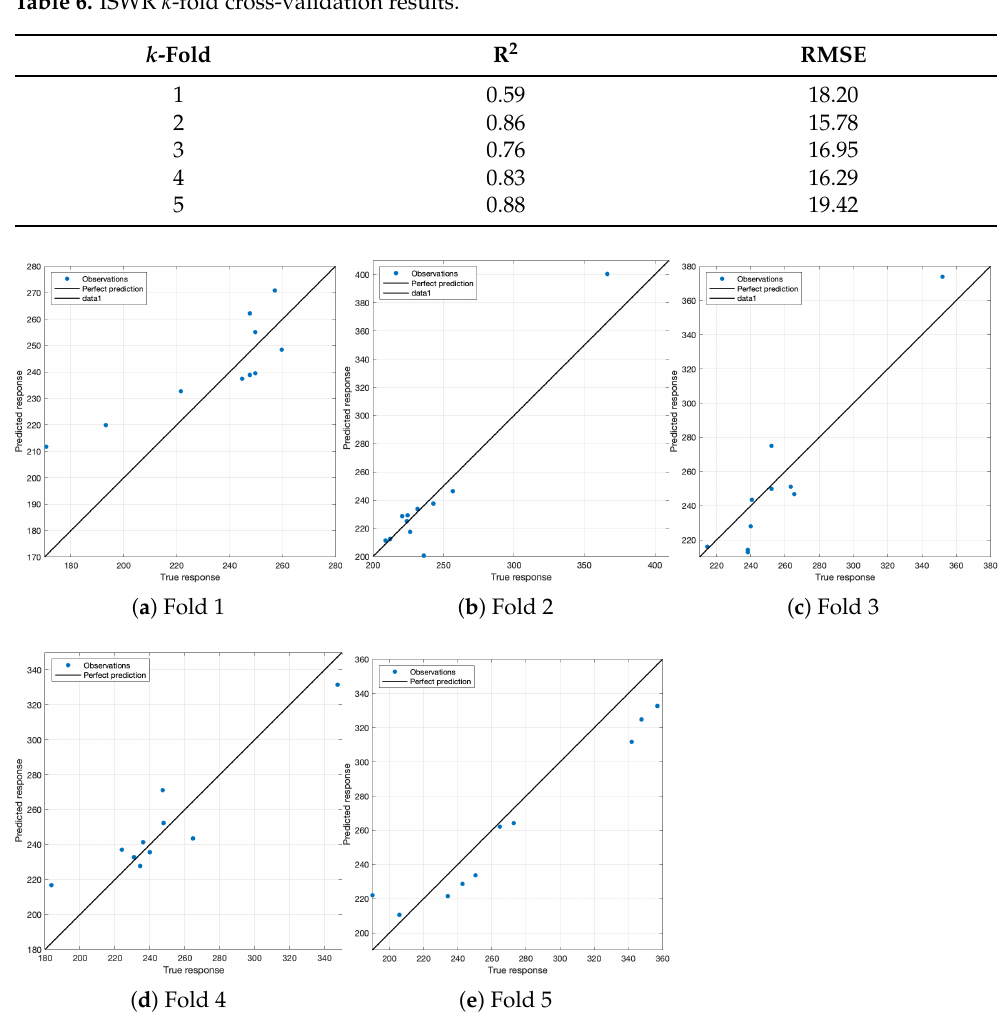
Figure 6. ISWR k-fold cross-validation